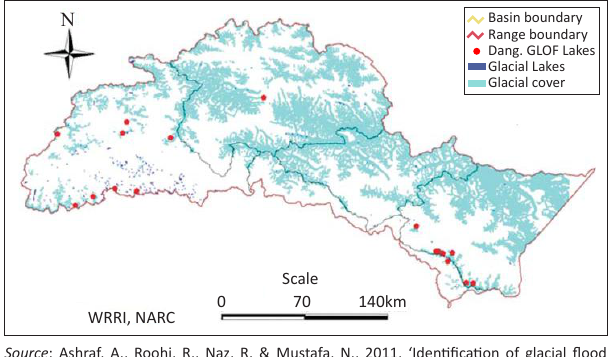
Source : Ashraf, A., Roohi, R., Naz, R. & Mustafa, N., 2011, ‘Identification of glacial flood hazards in Karakoram Range using remote sensing technique and risk analysis’, Scientific Journal of COMSATS – Science Vision 16 & 17, viewed 05 November 2013, from http://www.sciencevision.org.pk/BackIssues/Vol16_Vol17/11_Vol16_and_17_Identification_of_Glacial_Flood_Hazards_ArshadAshraf.pdf Dang, potentially dangerous, GLOF, glacier lake outburst flood. FIGURE 6: Glacial environment and lakes with a potential glacial lake outburst flood threat in different Karakoram river basins, Pakistan.